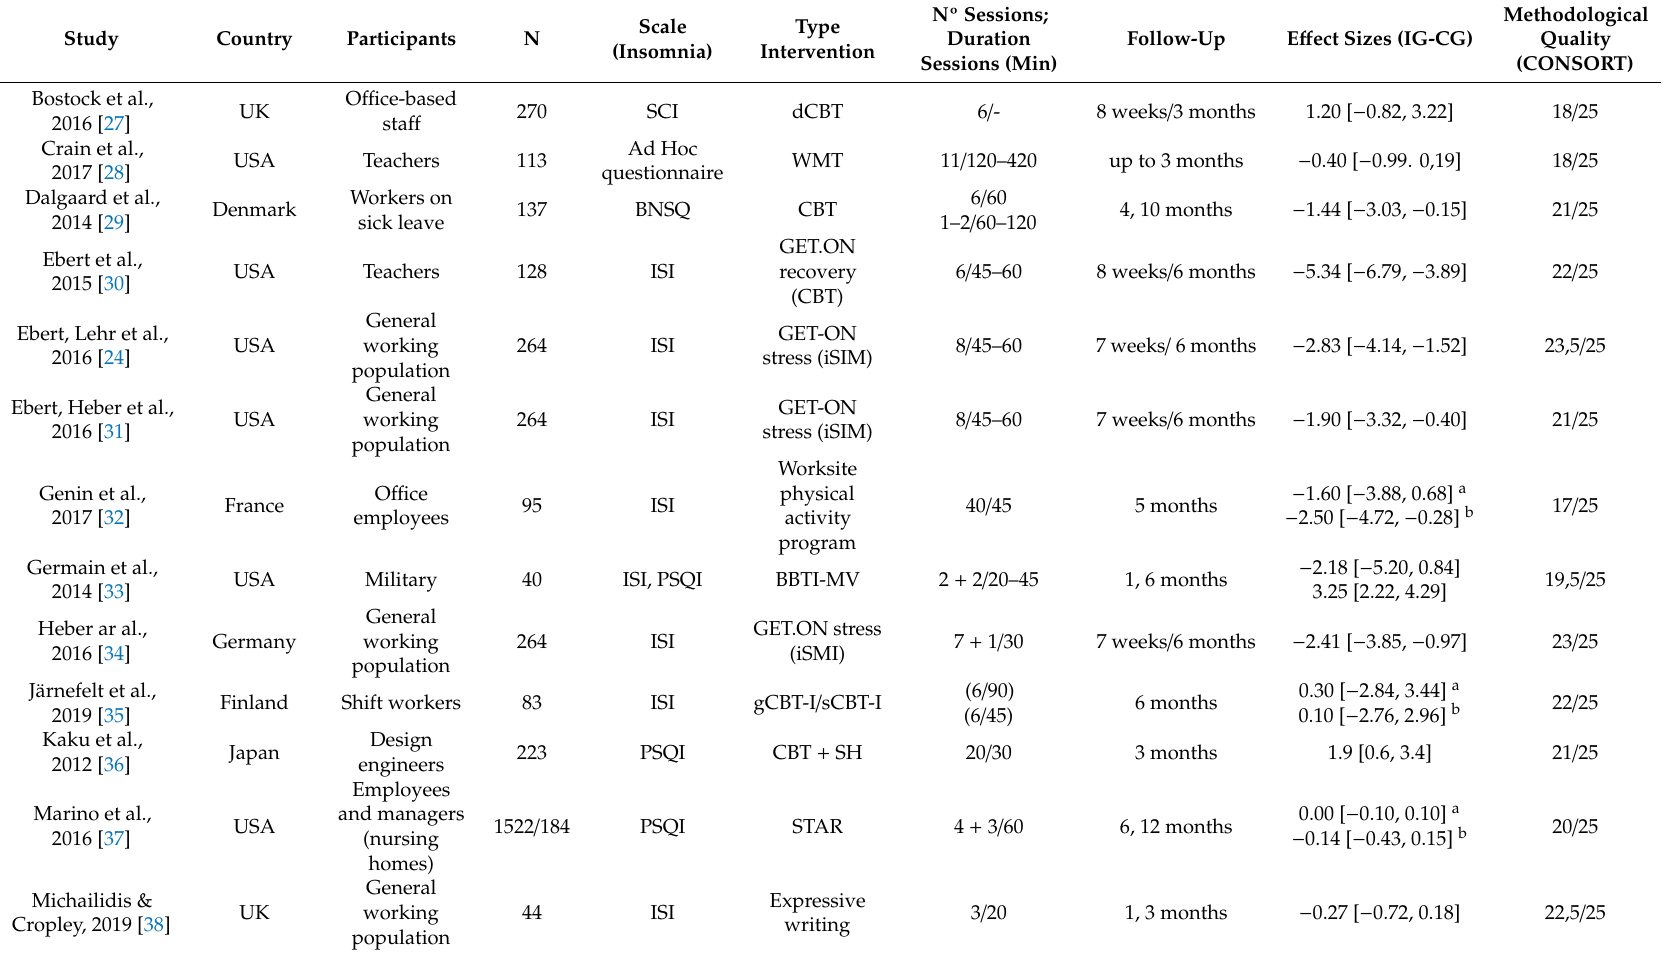
Table 1. Characteristic of studies included in the systematic review and